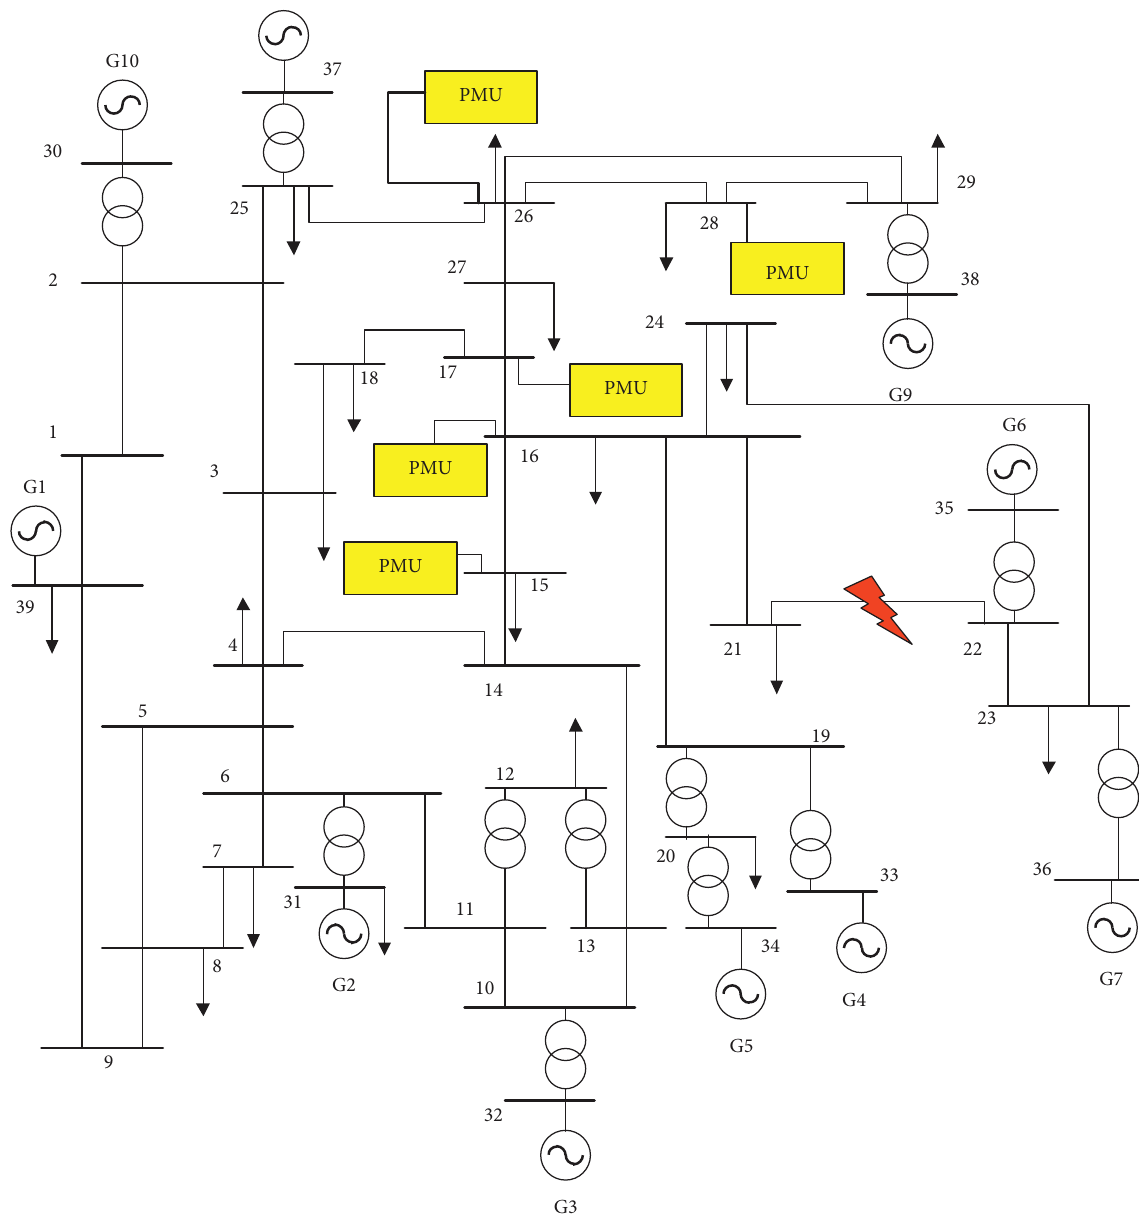
Figure 19: IEEE39-bus